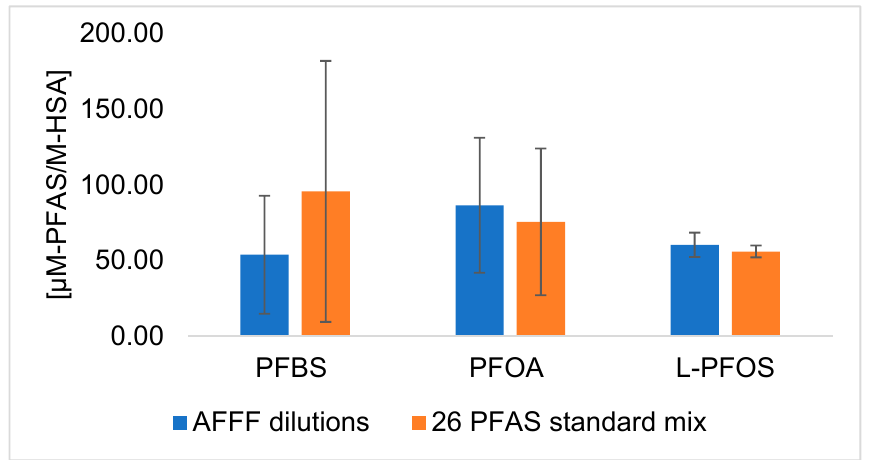
Figure 4. Residual PFAS quantified in digested HSA pellets, precipitated from equilibrium dialy- sis experiment.